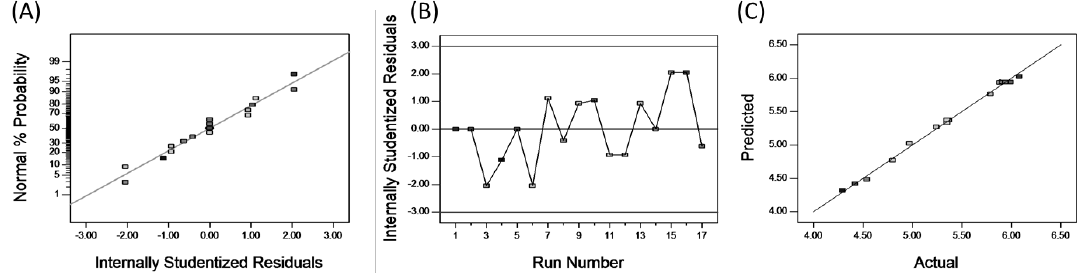
Figure 4. The normal probility plot of residuals ( A ); plot of internally studentized residuals versus experimental runs ( B ) and plot of predicted and actual values ( C ).